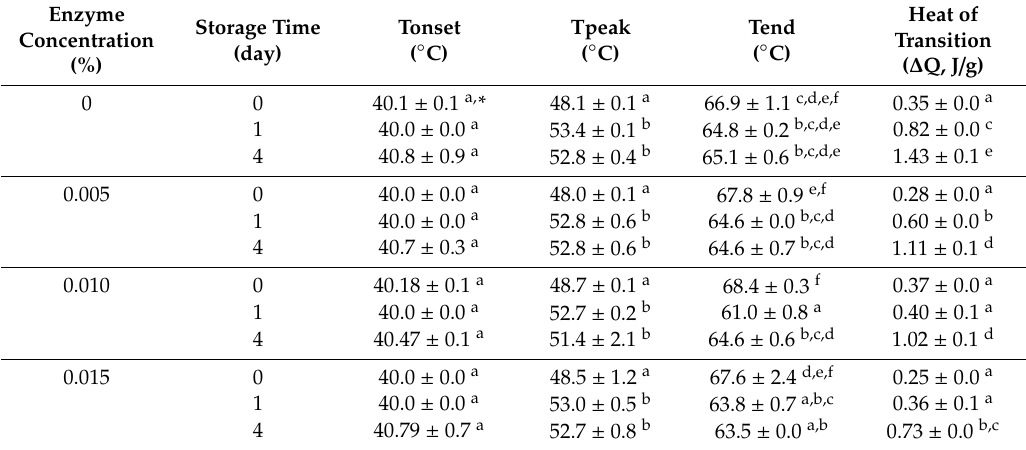
Table 4. Thermal characteristics of gluten-free rice bread prepared with #11 (1% gum, 100 g of water, a 5 min mixing time, and a 60 min fermentation time) during storage at 4 ◦